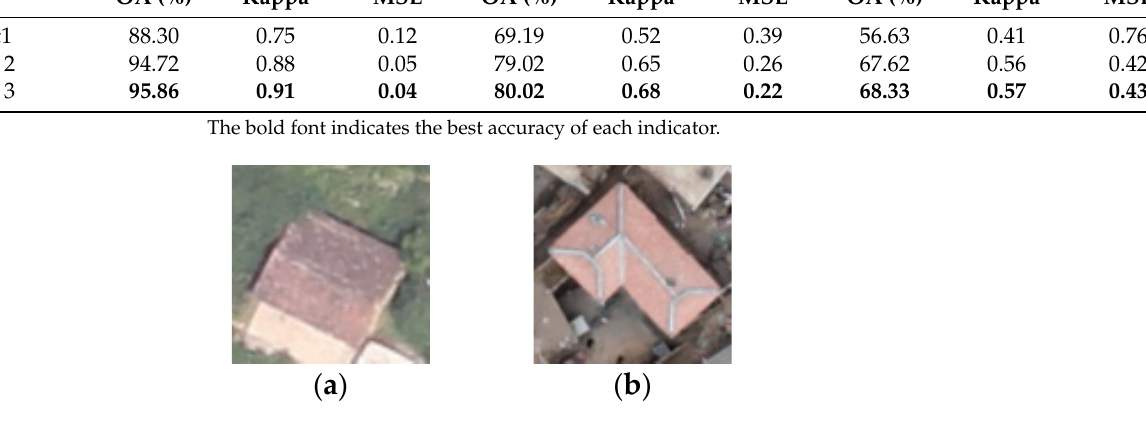
Figure 7. Examples of buildings in different areas: ( a ) Ludian dataset; ( b ) Yushu dataset.